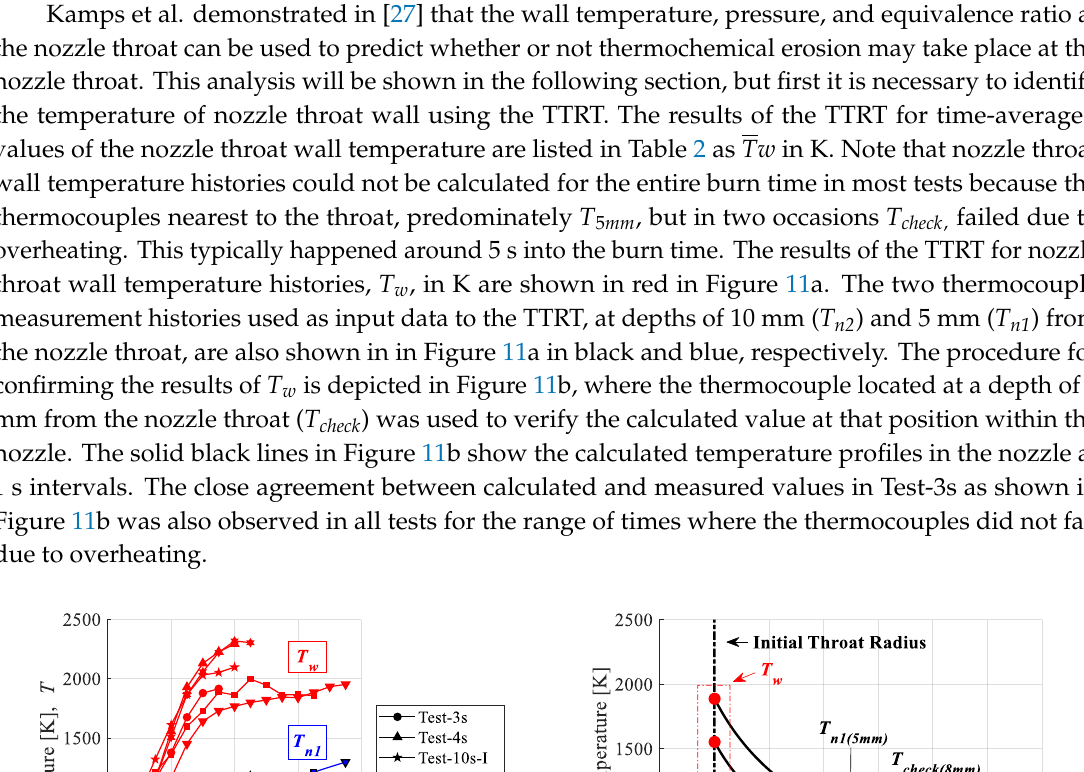
Figure 10. The NTRT+ analysis ( a ) propellant flow rates; ( b ) throat erosion and efficiency histories. 481